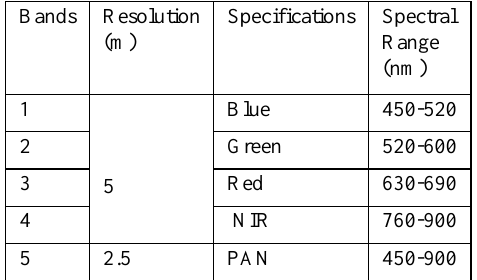
Table 2. Specifications of GOKTURK-2 (Kalkan et al., 2015).